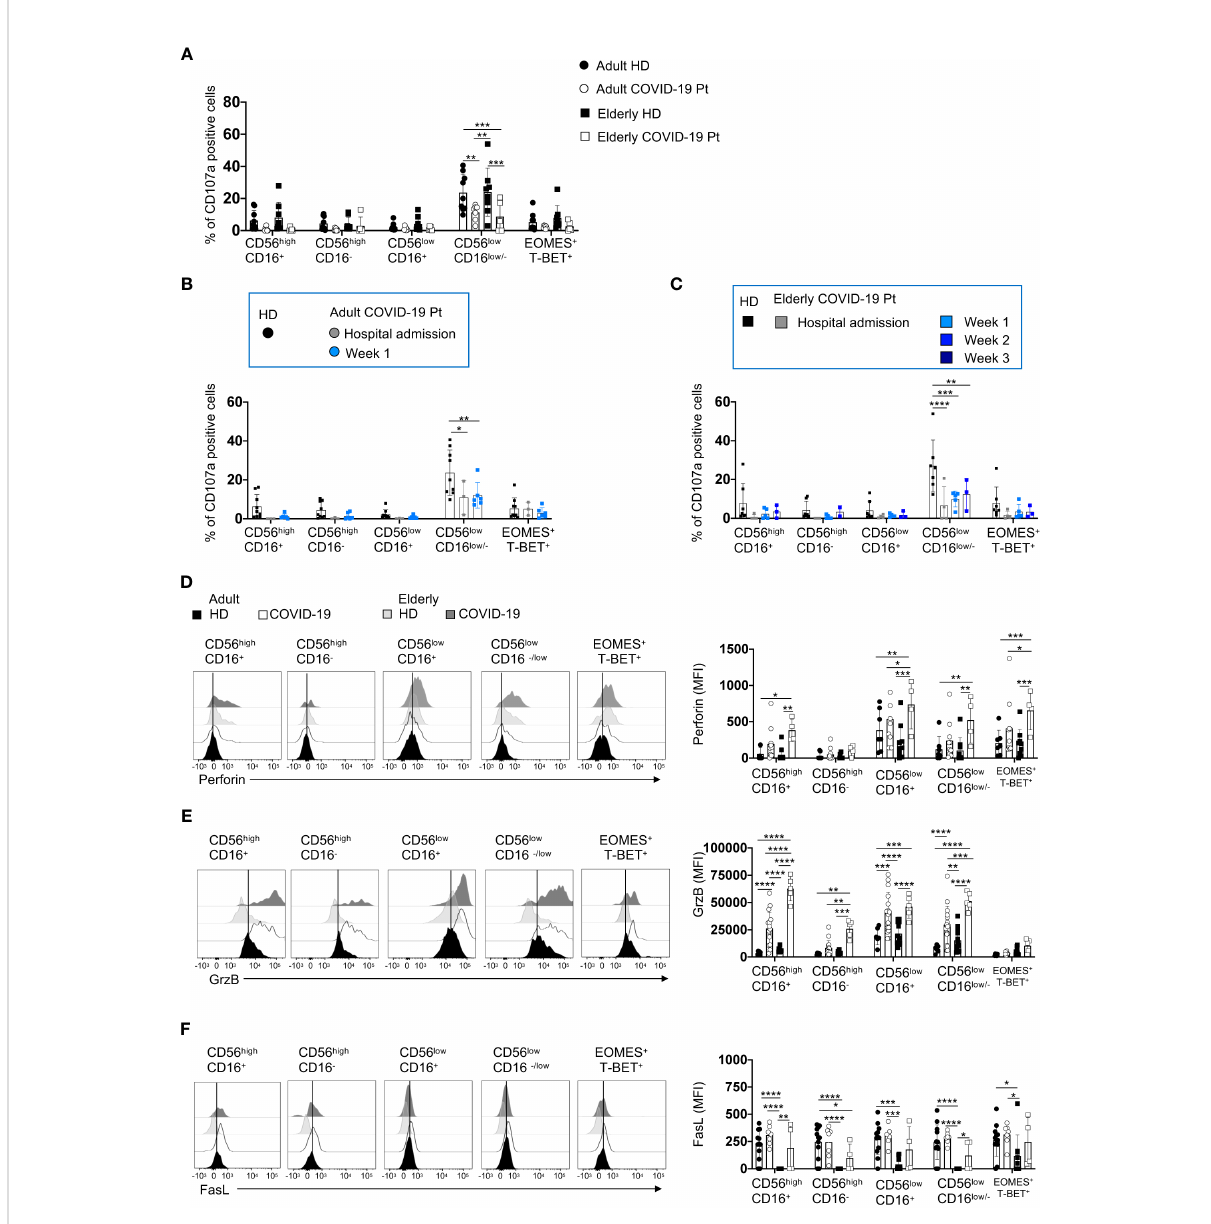
FIGURE 7 An impairment of degranulation ability characterizes both adult and elderly NK cell subsets. The percentage of K562 target cell-induced CD107a positive NK cell subsets from adult and elderly COVID-19 patients and healthy controls is shown early after hospital admission (A) and at different times after hospitalization in adult (B) and elderly (C) patients. Representative overlays and mean fl uorescence intensity (MFI) of Perforin (D) , Granzyme B (GrzB) (E) and FasL (F) expression by distinct NK cell subsets are reported for COVID-19 patients and age-matched controls. Histograms represent the mean ± SD. * p< 0.05, ** p< 0.01, *** p< 0.001, **** p< 0.0001. Two-way analysis of variance (ANOVA) Tukey ’ s multiple comparisons test and One way ANOVA Kruskal-Wallies test multiple